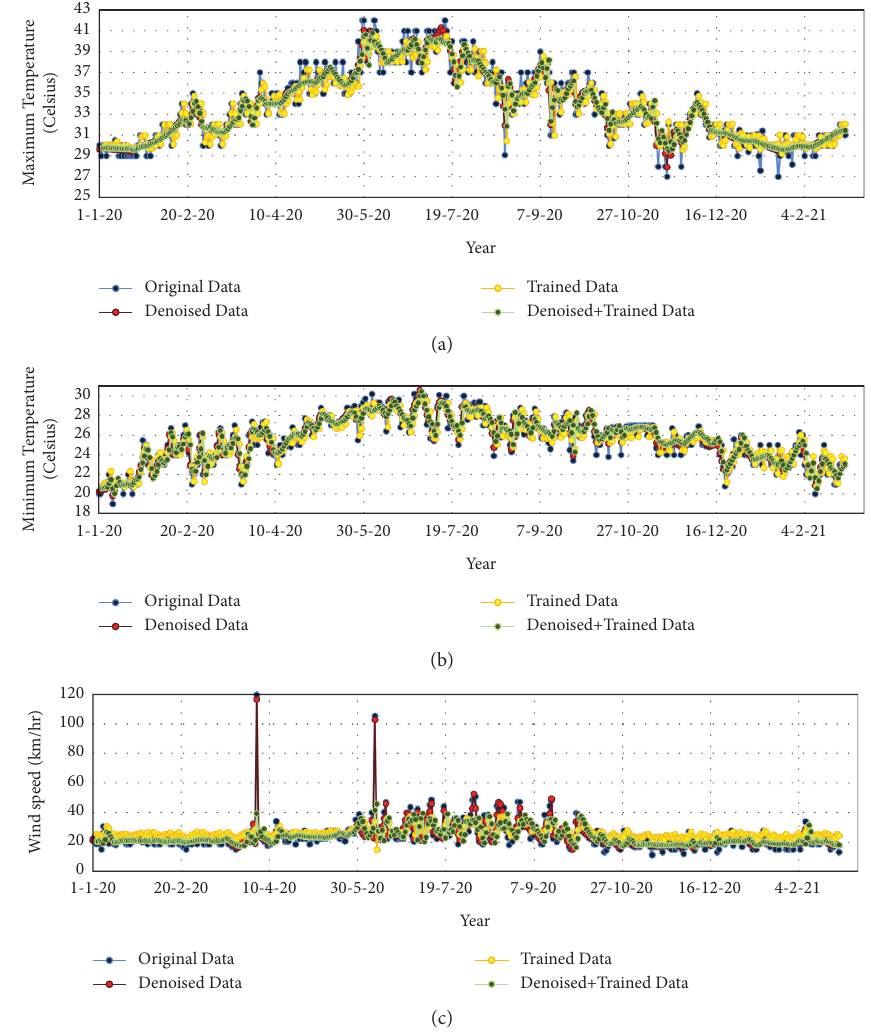
Figure 4: Original and denoised trained time series for Chennai. (a) Maximum temperature data, Chennai. (b) Minimum temperature data, Chennai. (c) Wind speed data, Chennai.